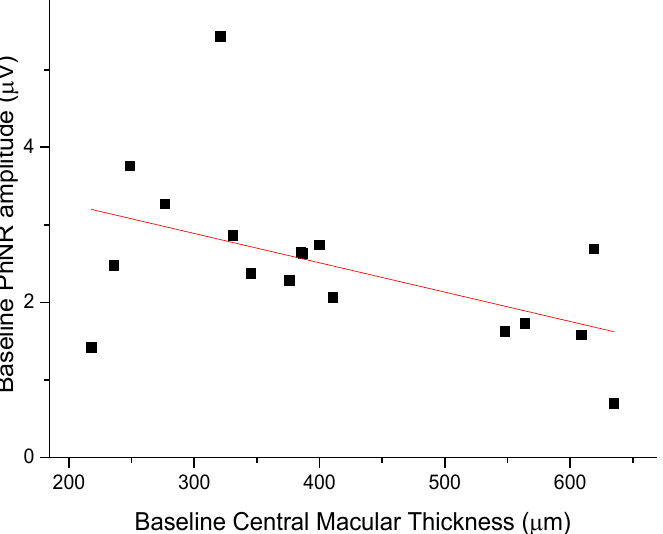
Figure 2. Baseline PhNR amplitude was negatively correlated with CMT (r = −0 .7, p < 0.01).